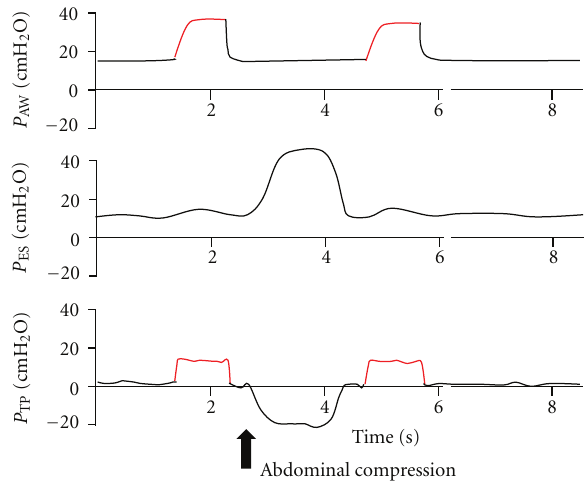
Figure 1: Pressure tracing of esophageal balloon with its tip in the stomach (60 to 70cm below the incisors). Black arrow indicates gentle compression of the abdomen by the examiner. Catheter position in the stomach is also indicated by the smooth nature of the pressure tracing of the esophageal balloon and the lack of the e ff ect of heart beat on the pressure tracing. P Aw = airway opening pressure, P = esophageal pressure, P = transpulmonary ES TP